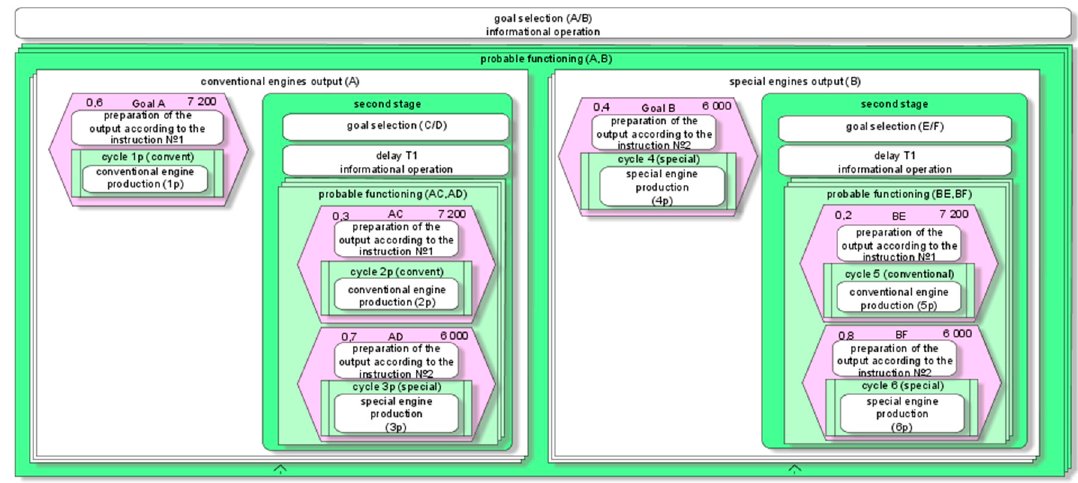
Figure 8. Diagrammatic ARIS model version 1 to estimate system dynamic capability indicator.